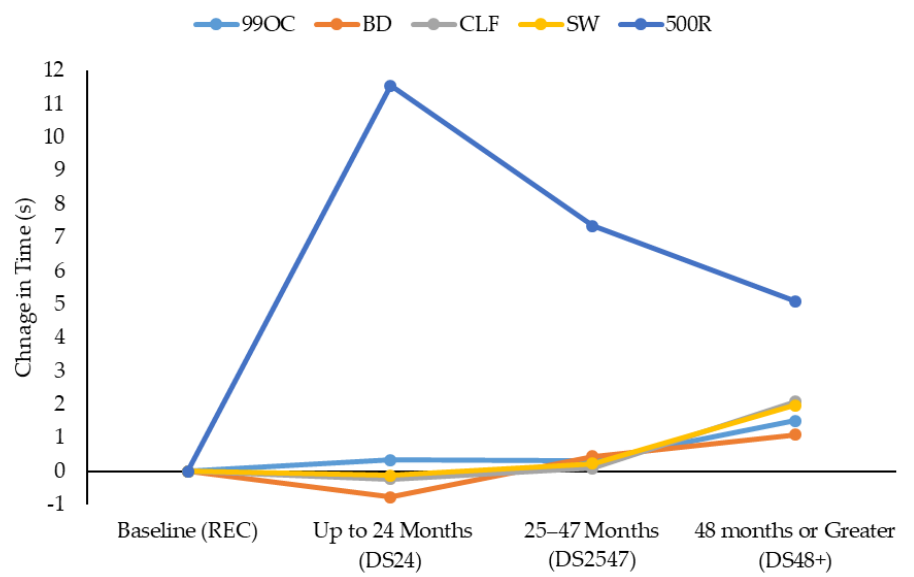
Figure 2. Difference in mean times for each WSTB task (99OC, BD, CLF, SW, and 500R) through the time points established in this study with the deputy sheriff groups (REC: baseline; DS24: up to 24 months working in custody; DS2547: 25 – 47 months working in custody; DS48+ 48 months or greater